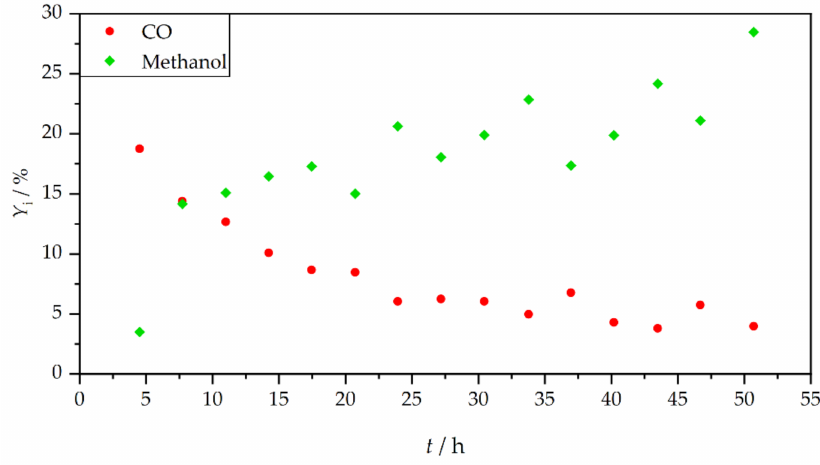
Figure 7. Interval yields of CO and methanol during the experimental run.